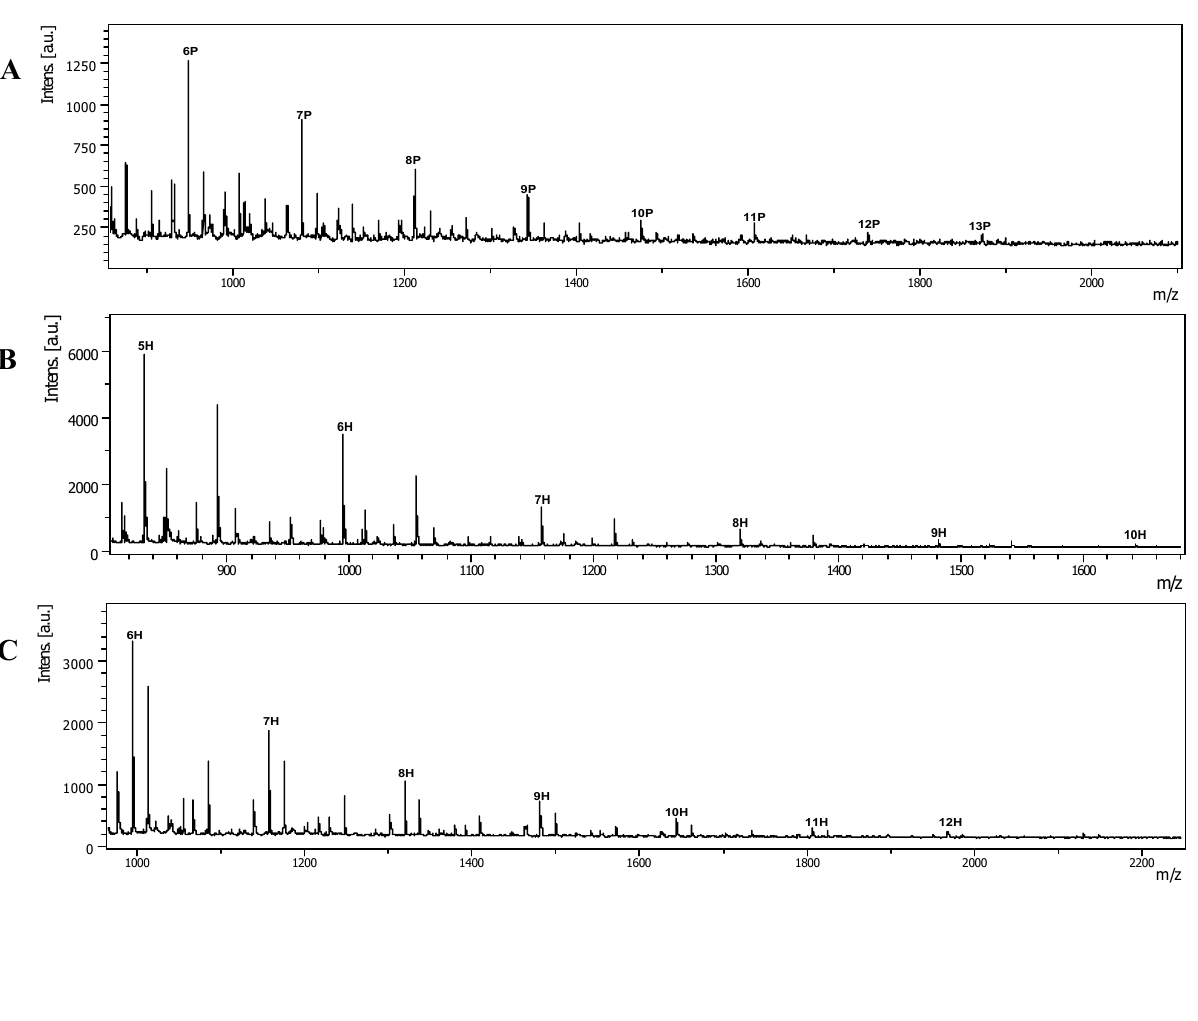
Figure 1. ( A ) MALDI-TOF MS spectrum of arabinoxylan. The mass difference of 132.1 Da between two neighboring peaks was observed. ( B ) The glucomannan spectrum with hexosyl units of 162.1 Da between two neighboring peaks is observed. ( C ) MALDI-TOF MS spectrum of dextran. ( D ) Mass spectrum of arabinogalactan with mixed pentose and hexose in polysaccharide. Experimental conditions: 2,5-DHB was used as matrix and the ratio of matrix to saccharide was 10:1. A Smartbeam 200 Hz solid-state laser was used. The sample load is set at 2 µL of 1,000 ppm polysaccharide solution in each dot on the steel